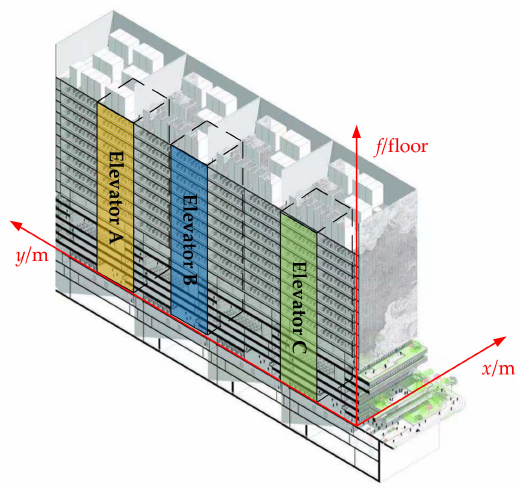
Figure 9. The tested scenario in Beijing.